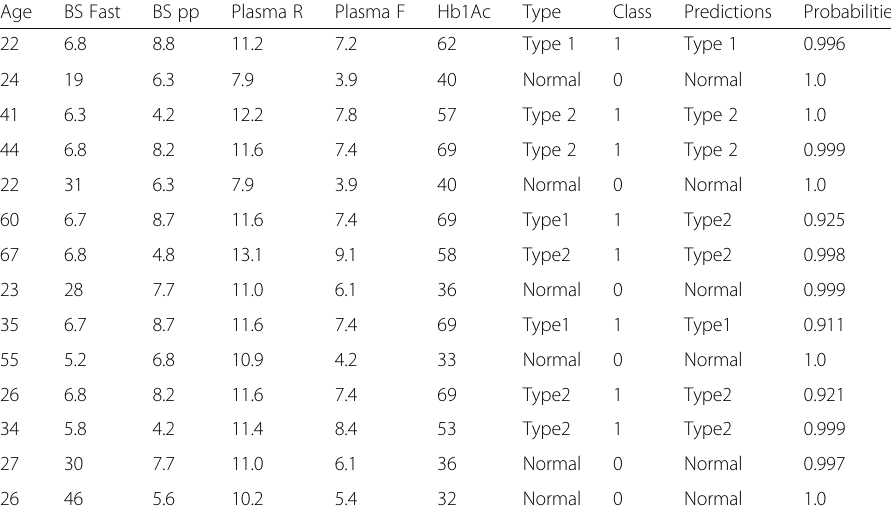
Table 6 Prediction results for the diabetes type dataset